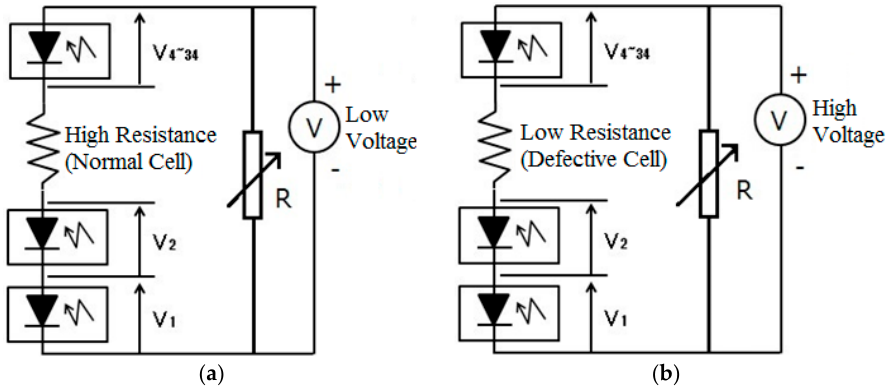
Figure 8. The equivalent circuit of the solar module: ( a ) Normal cell shaded condition; ( b ) Defective cell shaded condition.